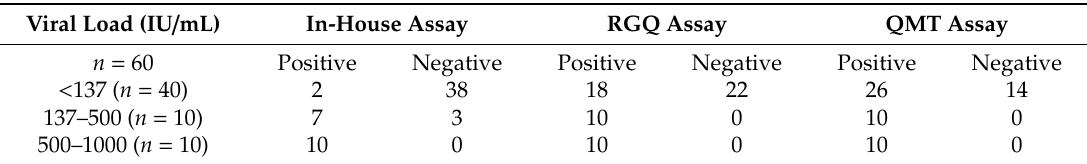
Table 5. Comparison of the performance of in-house, RGQ, and QMT assays for the analysis of frozen residual plasma specimens positive in Roche assay.